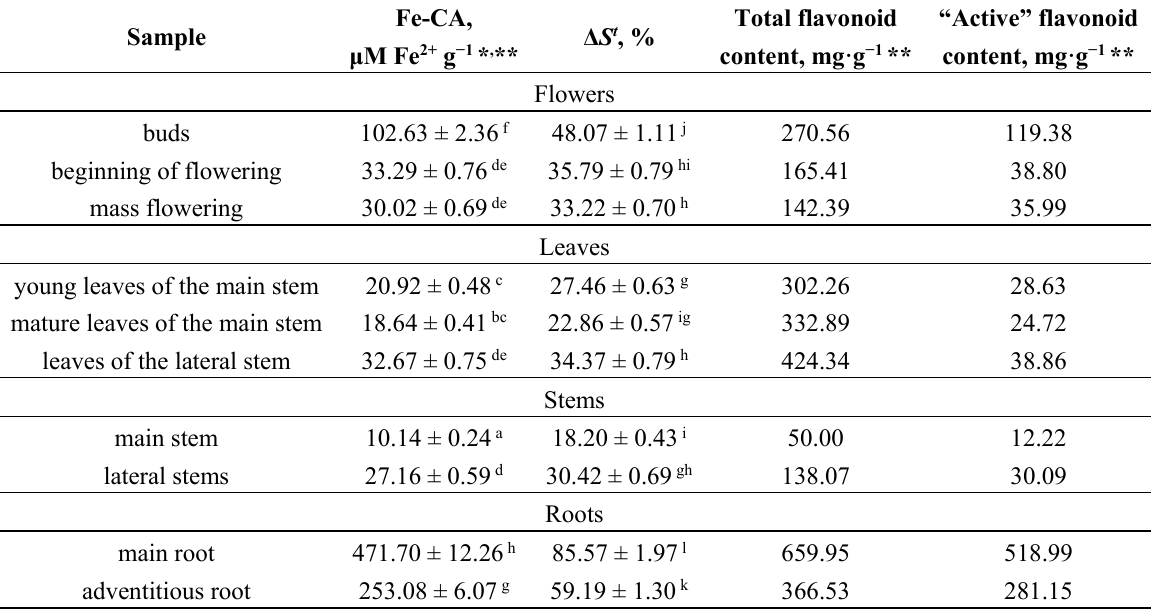
Table 3. Fe 2+ -Chelating activity (Fe-CA), reduction of total peaks areas ( Δ S t ) and chemical parameters of extracts from different S. baicalensis